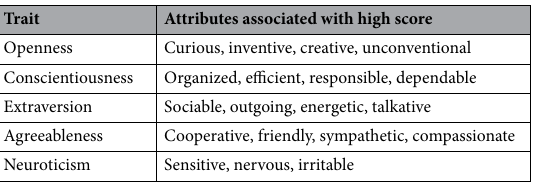
Table 1. An overview of the Big Five traits 56 used to assess the participants’ personality, and traits associated with high scores in the respective